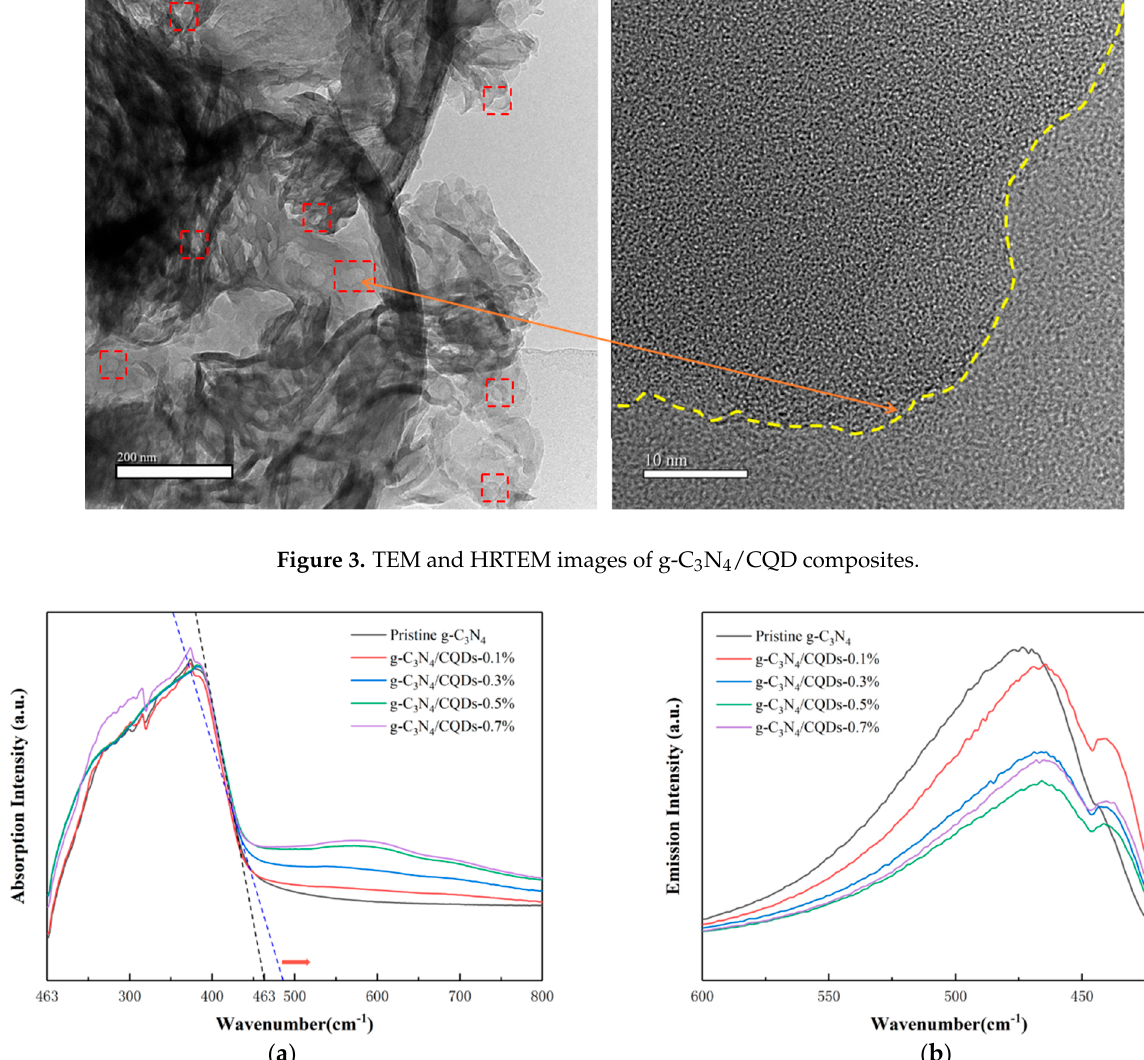
Figure 2. SEM images of ( a ) pristine PCL electrospun membranes, ( b ) modified PCL electrospun membranes, ( c ) PCL-g-C 3 N 4 /CQDs electrospun membranes, and ( d ) modified PCL-g-C 3 N 4 /CQDs electrospun membranes.